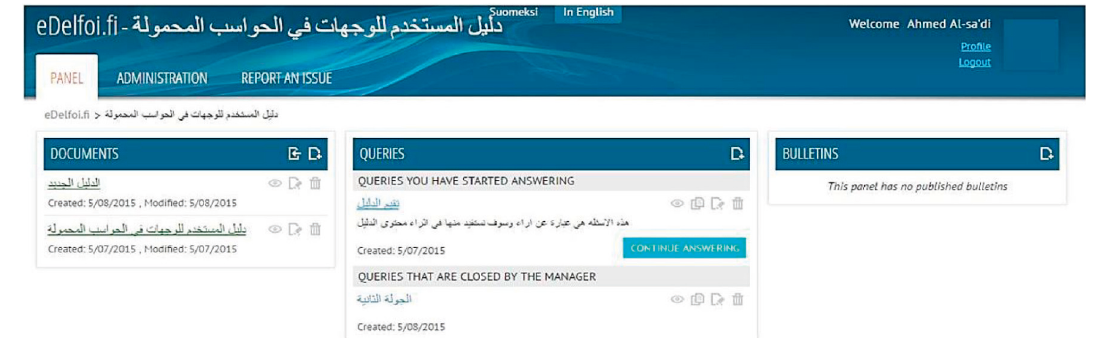
Figure 2: Setup of the Delphi study. Table 2: Demographic information of participants in the Delphi